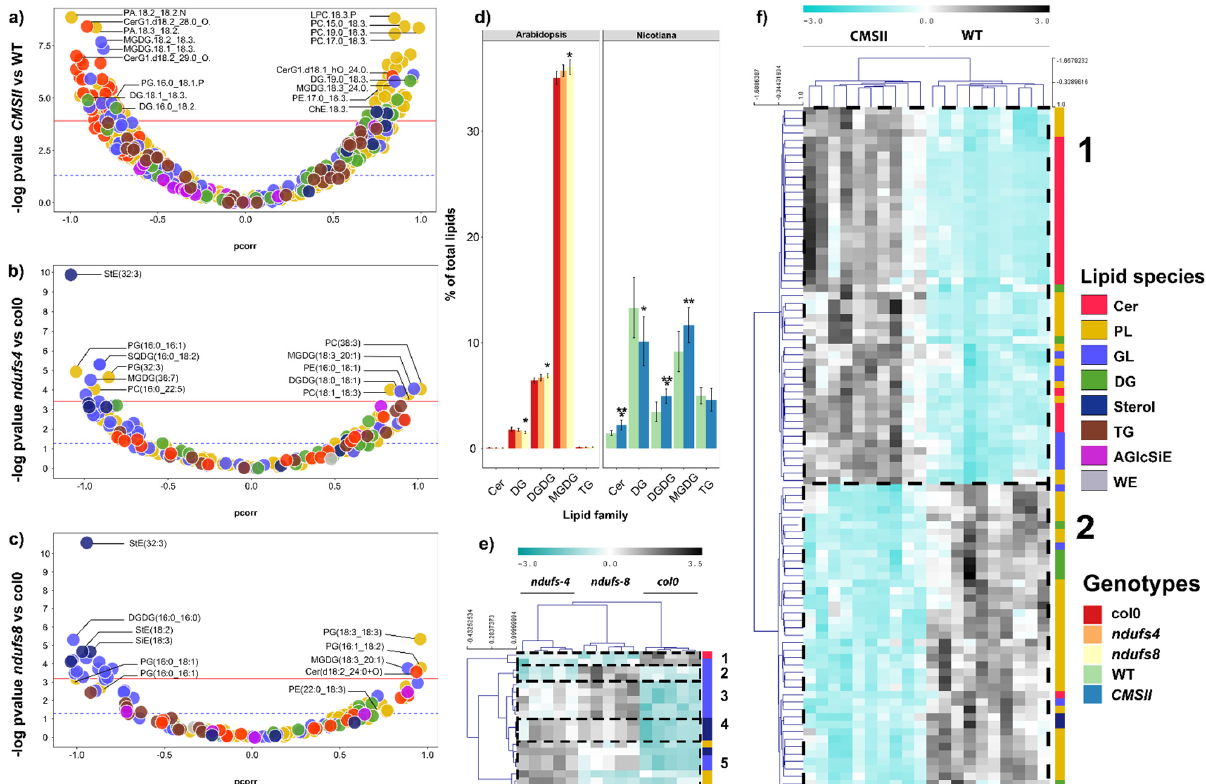
Figure 2. Leaf lipidome from LC ‐ MS analysis in wild ‐ type and CI mutants: CMSII (tobacco) and ndufs4 and ndufs8 (Arabidopsis). ( a – c ) Volcano plots showing the weight in sample discrimination (p corr value from OPLS ‐ DA multivariate analysis) against the p ‐ value (Welch t ‐ test, univariate analysis) to show best lipid biomarkers between mutants (on the left) and wild ‐ type (on the right). ( d ) Relative LC ‐ MS signal of whole lipid families in percentage of total lipid signal. ( e – f ) Heat map and hierarchical clustering (left) showing lipids that differed significantly ( p < 0.05 with Bonferroni correction, two ‐ way ANOVA) between genotypes. The colour scale stands for relative metabolite content from low (cyan) to high (grey, colour scale on top). The colour legend on the righthand side of